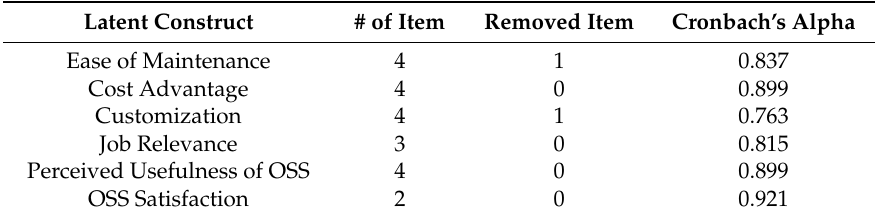
Table 4. Results of reliability